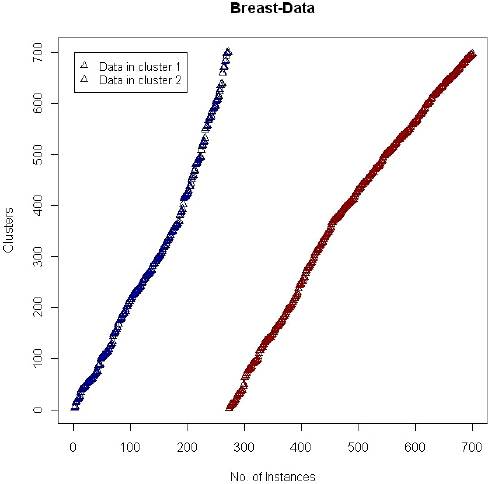
Fig. 27. Reallocated 699 data by KEFCM wd .